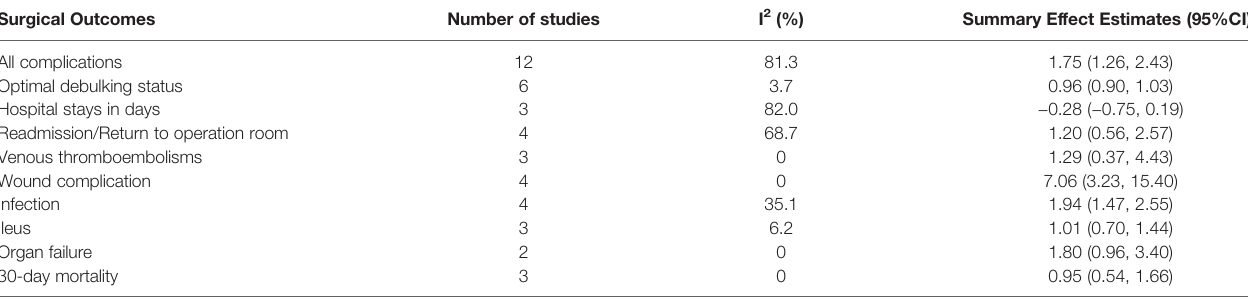
TABLE 2 | Surgical outcomes for obese vs non-obese patients after primary ovarian cancer surgery. Surgical